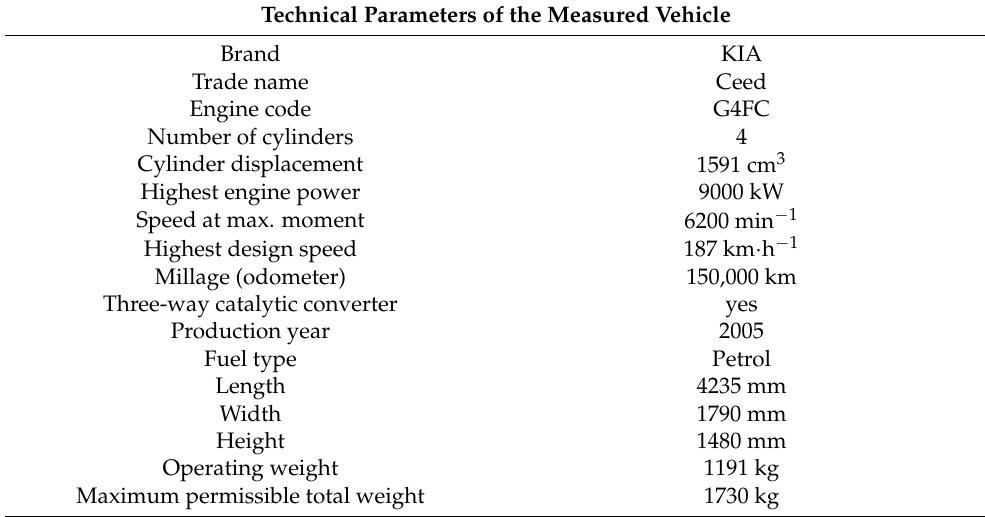
Table 1. Technical data of the measured vehicle [author].